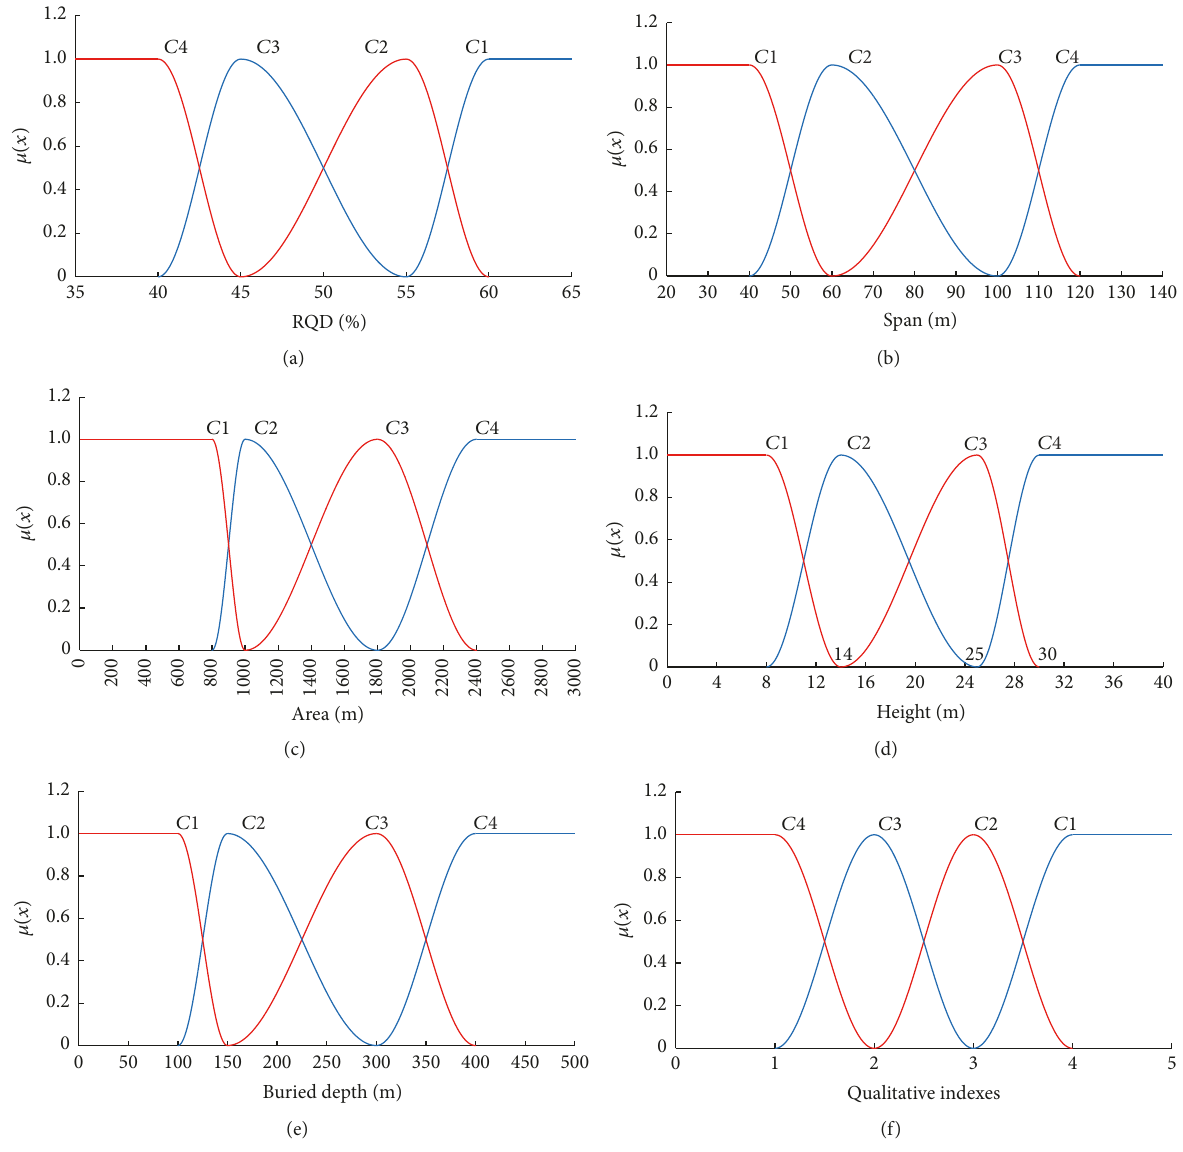
Figure 3: The single index measurement functions for evaluation indexes of underground goafs. The graphs (a), (b), (c), (d), and (e) show the functions of RQD, span, area, height, and buried depth, respectively. The graph (f) shows the function of rock mass structure, geological structure, groundwater, impact of groundwater, mining impact, condition of adjacent underground goaf, pillar size and layout, and engineering